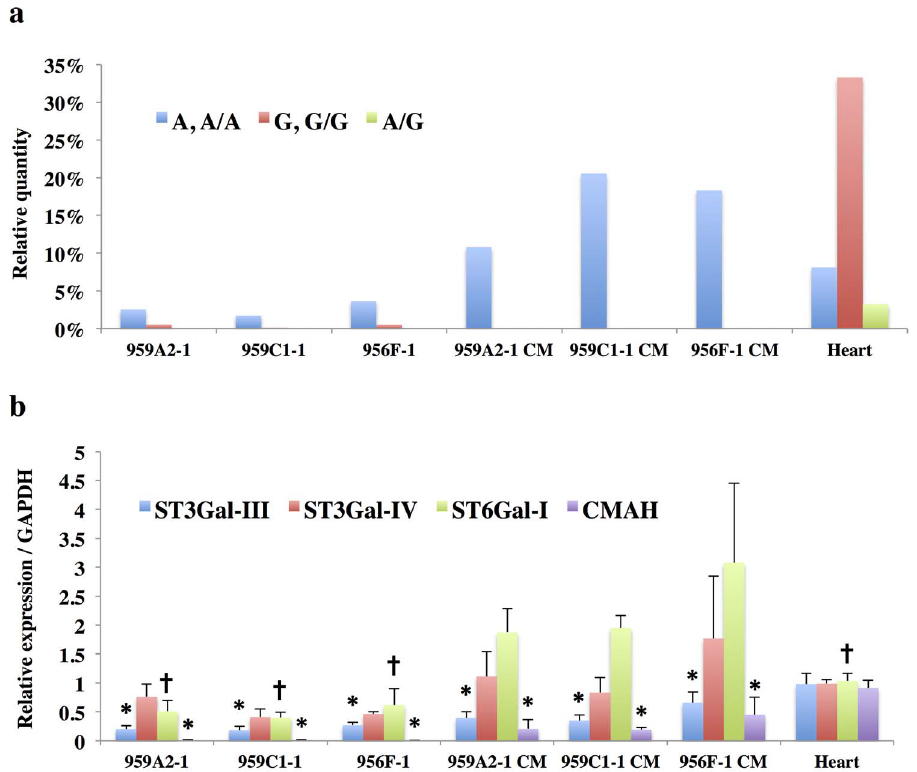
Figure 10. Rarely expressed NeuGc-containing glycans in iPSCs and iPSC-CMs. (a) Relative quantities of NeuAc- and NeuGc-containing glycans; Monosialoglycans containing NeuAc and Disialoglycans containing two NeuAc (A, A/A): the total volume of M1, M2-1, M2-2, M5-M8, M10- M14, M16-M19, M20-2, M21-M23, D4-1, D4-2, D6, D7, D9, D10-1, D12, Disialoglycan containing NeuAc and NeuGc (A/G): D11, Monosialoglycan containing NeuGc and Disialoglycan containing two NeuGc (G, G/G): the total volume of M2-3, M3, M4, M9, M15, M20-1, D1-D3, D5-1, D5-2, D8, D10-2. (b) Transcript expression of ST3Gal-III, ST3Gal-IV, ST6Gal-I, and CMAH; Transcript expression of glycosyltransferases in iPSCs, iPSC-CM, and heart cells was analyzed by real-time PCR. Results are expressed as the mean 6 standard deviation. *P , 0.05 vs. Heart, { P , 0.05 vs. iPSC-CM (all of the 959A2-1 CM, 959C1-1 CM and 956F-1 CM).